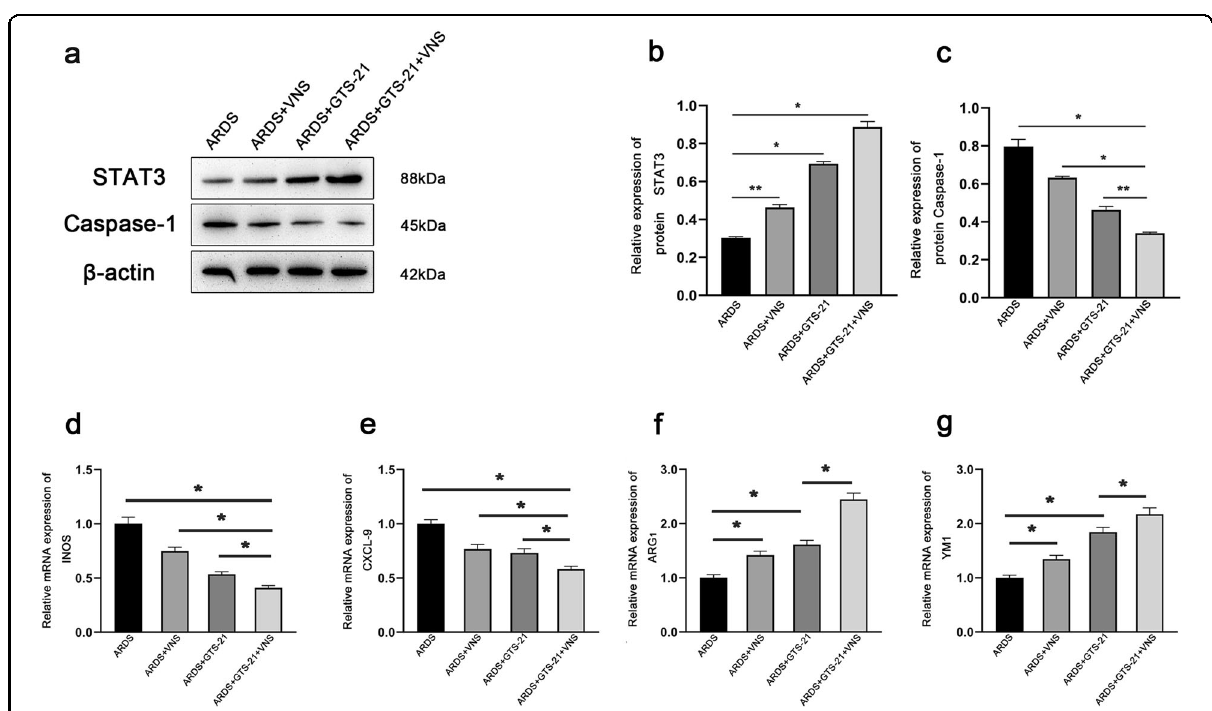
Fig. 3 The α 7nAchR agonist, GTS-21, can enhance the effects of VNS on STAT3, Caspase-1, and M1M2 macrophage phenotypes. a Representative western blotting images of STAT3 and Caspase-1 expression in the ARDS group, ARDS + VNS group, ARDS + GTS-21 group, and ARDS + GTS-21 + VNS group ( n = 6 biological replicates). b , c Comparison of mean intensity ratios for STAT3 and Caspase-1 in the ARDS group, ARDS + VNS group, ARDS + GTS-21 group, and ARDS + GTS-21 + VNS group ( n = 6 biological replicates). d – g The mRNA levels of M1 macrophage markers, iNOS and CXCL-9, and the mRNA levels of the M2 macrophage markers, Arg1 and Ym1, were measured in the ARDS group, ARDS + VNS group, ARDS + GTS- 21 group, and ARDS + GTS-21 + VNS group by qPCR and normalized to GAPDH mRNA levels ( n = 6 biological replicates). The results are expressed as the mean ± SEM ( n = 6 biological replicates); * p < 0.05, ** p <